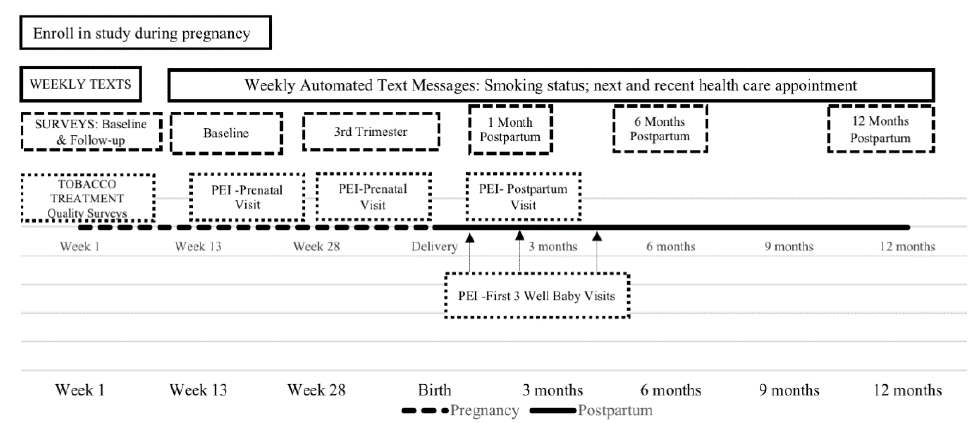
Figure 1. Msg4Moms cohort study flow